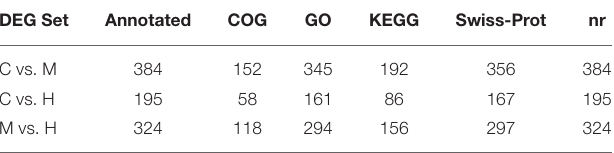
TABLE 4 | Statistics of the number of DEGs annotated.